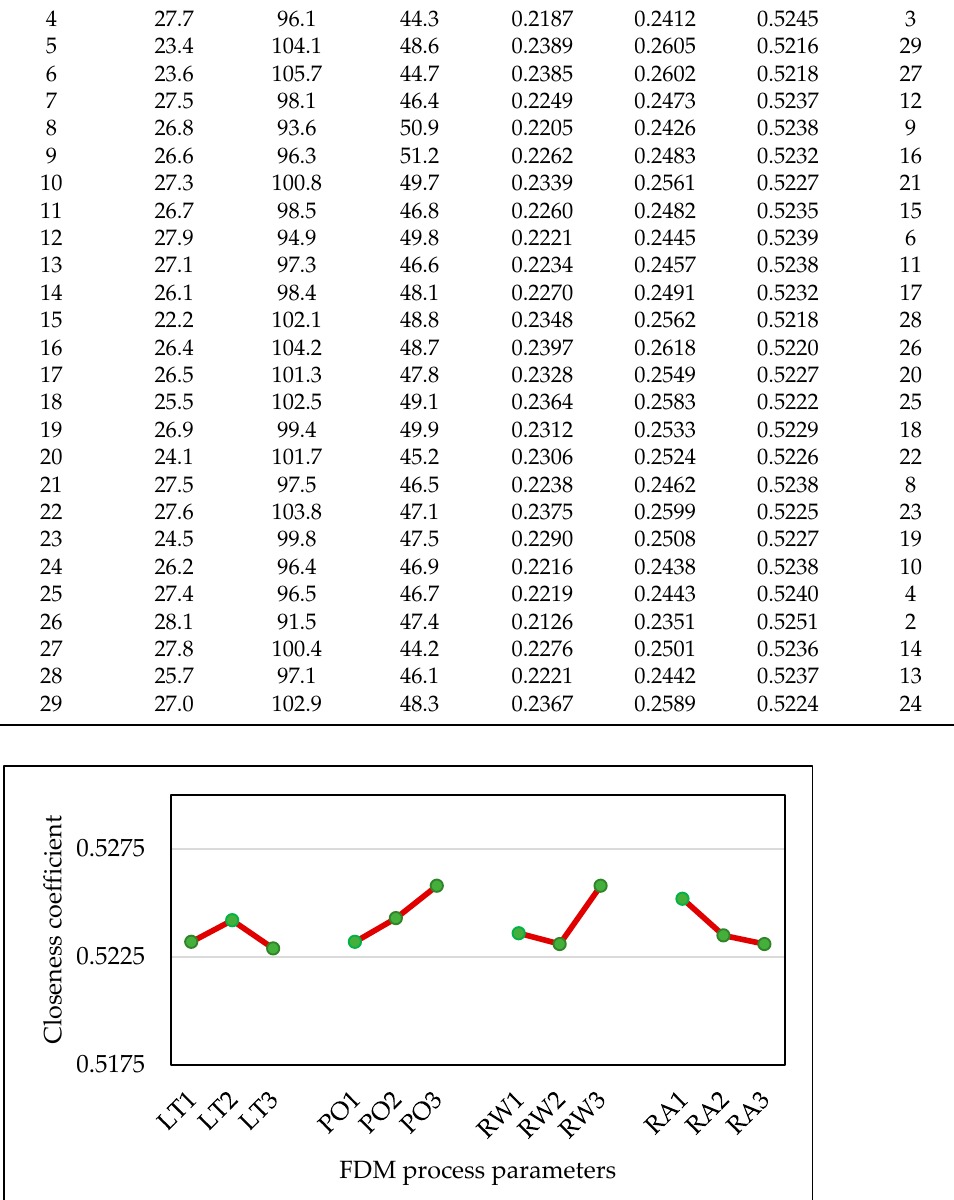
Table 7. Mean closeness coefficient for process parameters.